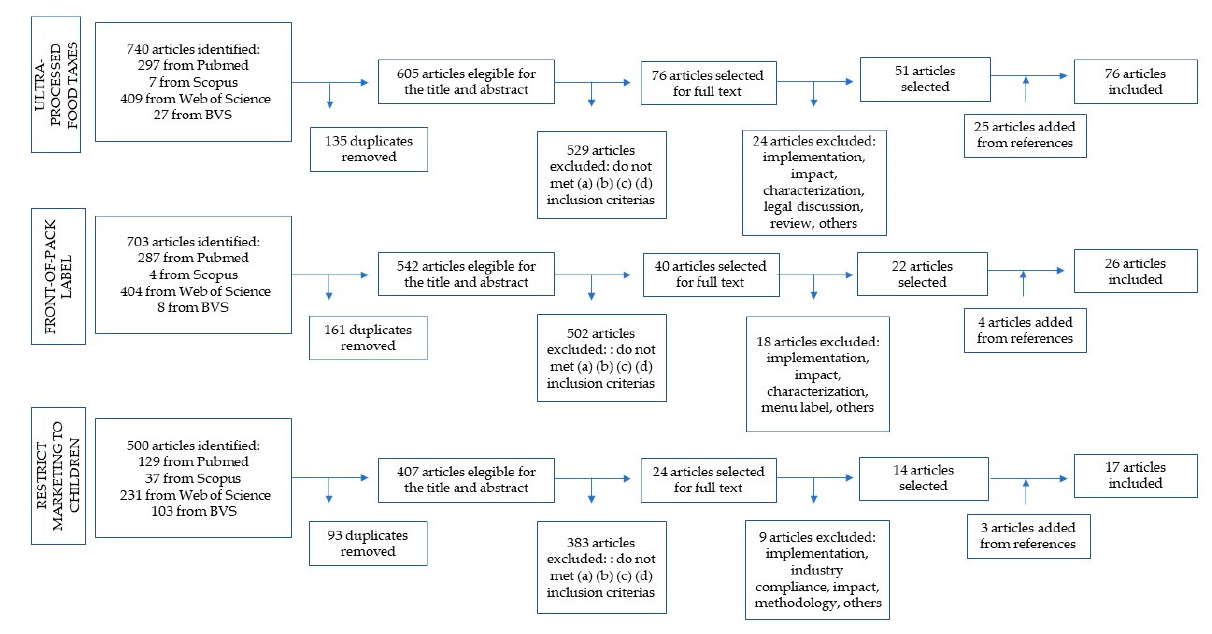
Figure 2. Scoping review flowchart.